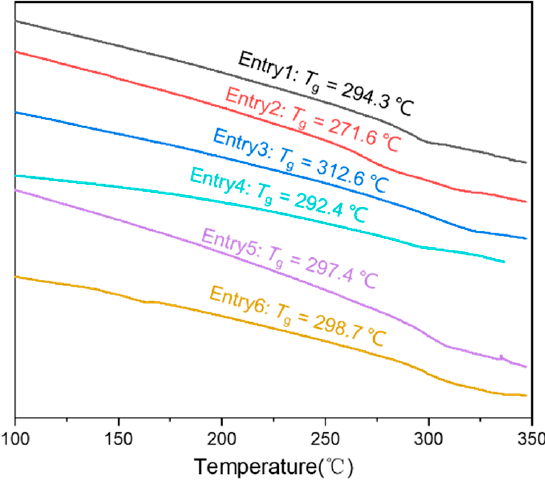
Figure 5. DSC curves of NB/MA copolymers obtained by Ni1 and Ni2 .